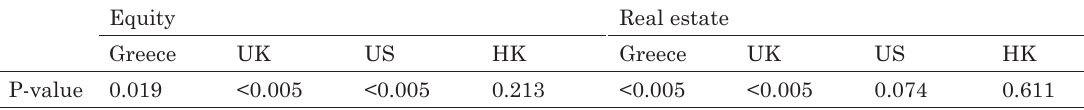
Table 3 . The result of the normality test